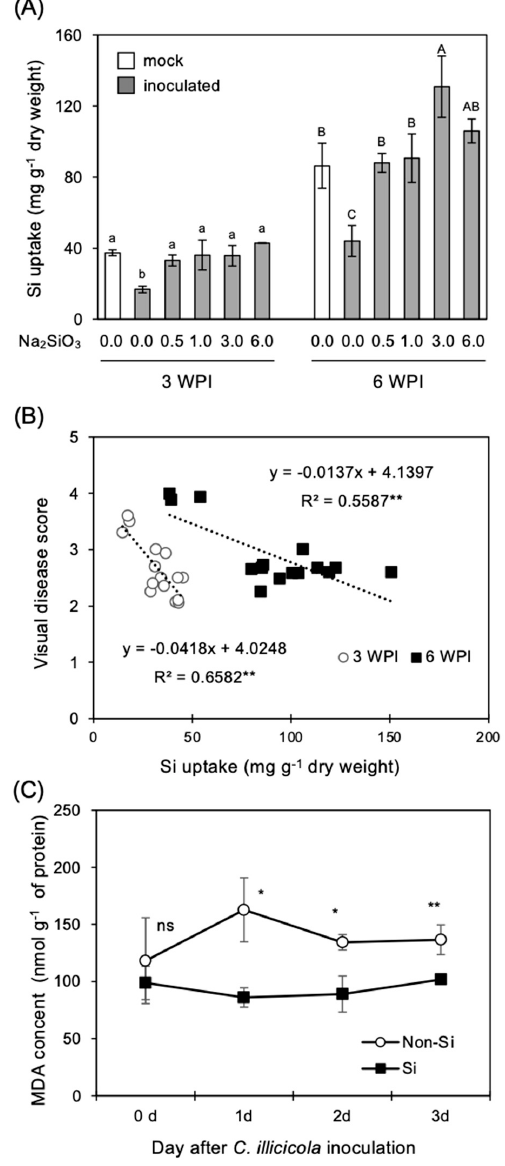
Figure 2. Correlation analysis of ( A ) shoot Si content and soil Si concentration, ( B ) disease severity at 3 and 6 WPI and Si uptake, and ( C ) MDA content in the roots and Si treatment ( n = 12). Different letters (lowercase for 3 WPI, uppercase for 6 WPI) indicate significant differences among treatments ( p < 0.05), as per Tukey’s HSD test. Asterisks indicate significant difference between control (untreated) and Si-treated seedlings ( t test, * and ** indicate p < 0.05 and 0.01, respectively). Si uptake in the shoot was negatively correlated with RCR severity in the roots at both 3 WPI (R 2 = 0.66, p < 0.001) and 6 WPI (R 2 = 0.56, p < 0.001) (Figure